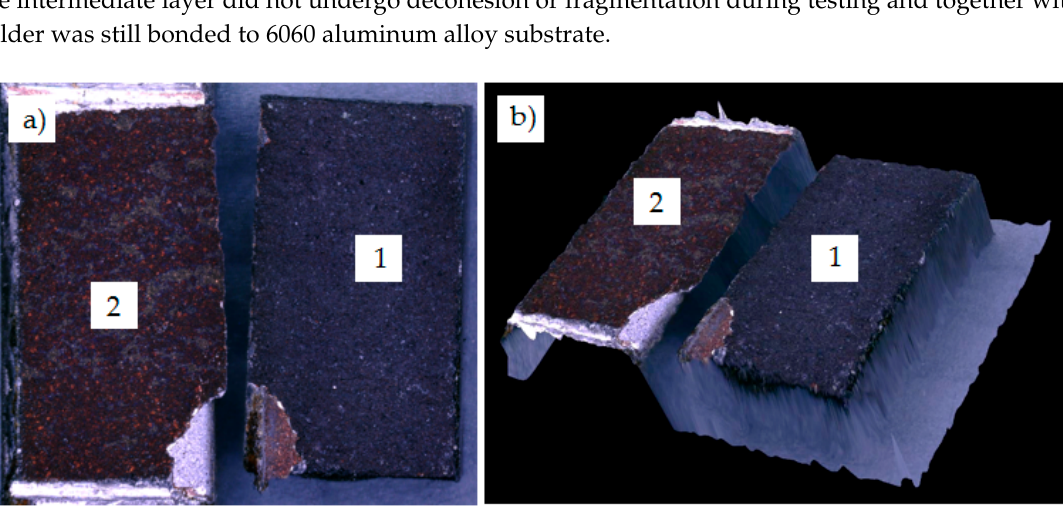
Figure 11. Adhesive fracture in solder joint under shear test (sample no. 2) ( a ) and 3D view of fracture ( b ); 1—graphite composite; 2—Cu coating on 6060 aluminum substrate.